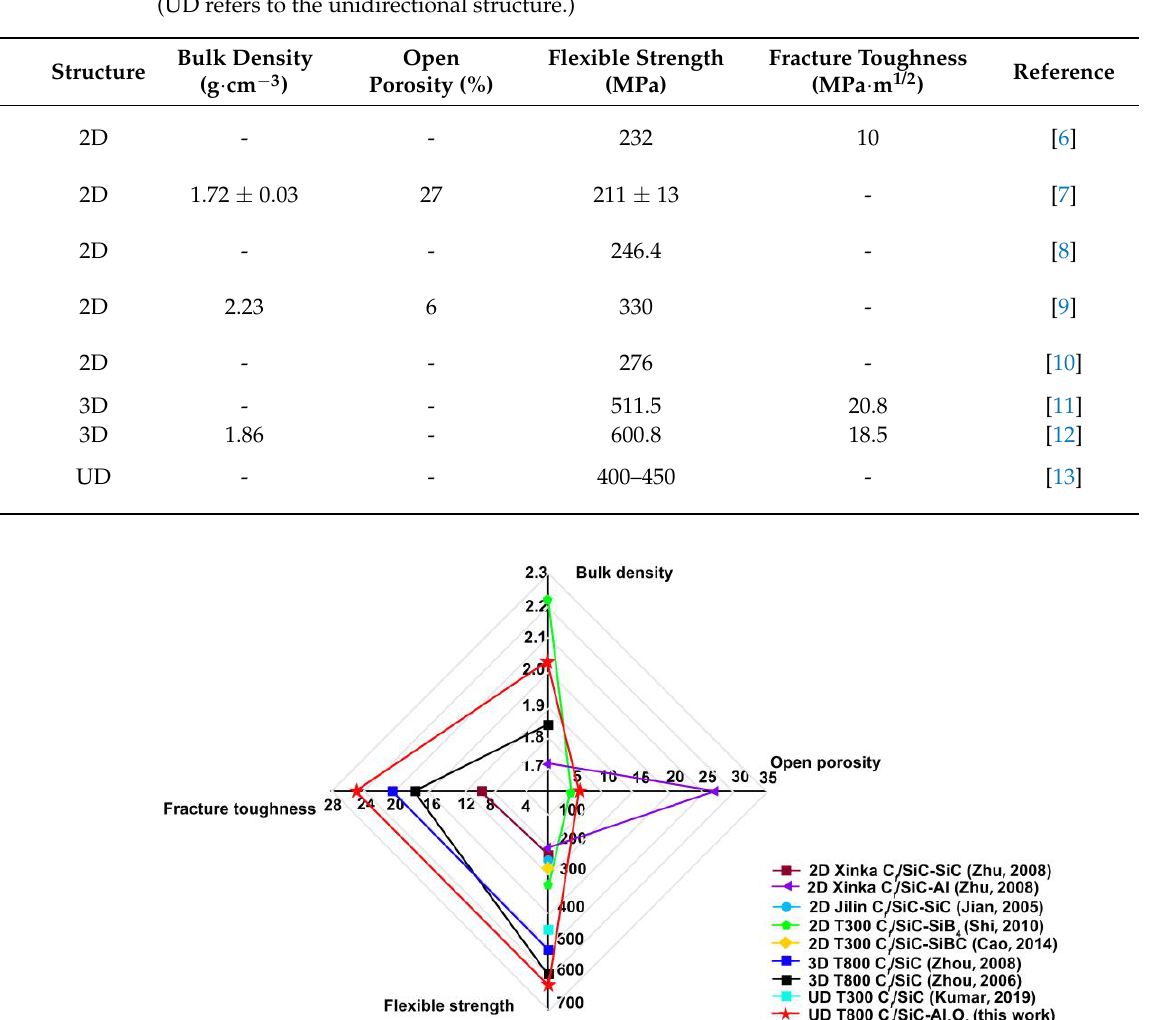
Table 4. General and mechanical properties of other C f /SiC composites in previous works [6 – 13]. (UD refers to the unidirectional structure.)